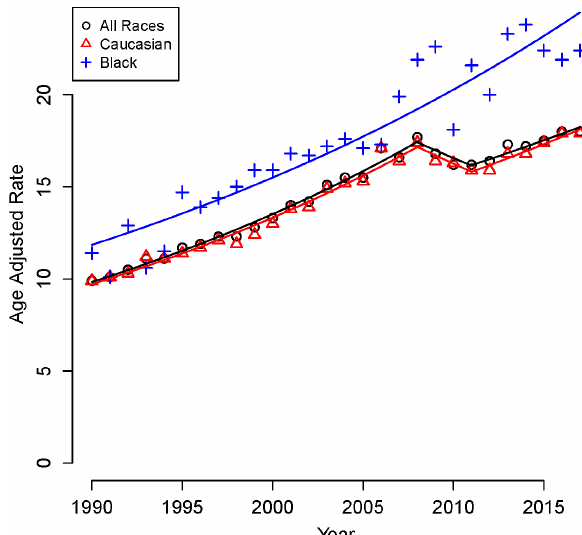
Figure 1: Stage-stratified, age-adjusted rates of RCC per 100,000 population, 1990–2017.